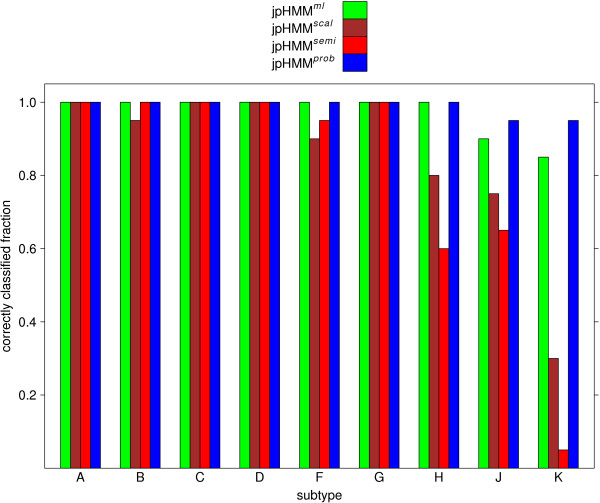
The fraction of correctly classified sequences forTpure. This fraction is shown for the application of jpHMM ml, jpHMM scal, jpHMM semi, and jpHMM prob to Tpure, stratified by subtypes.